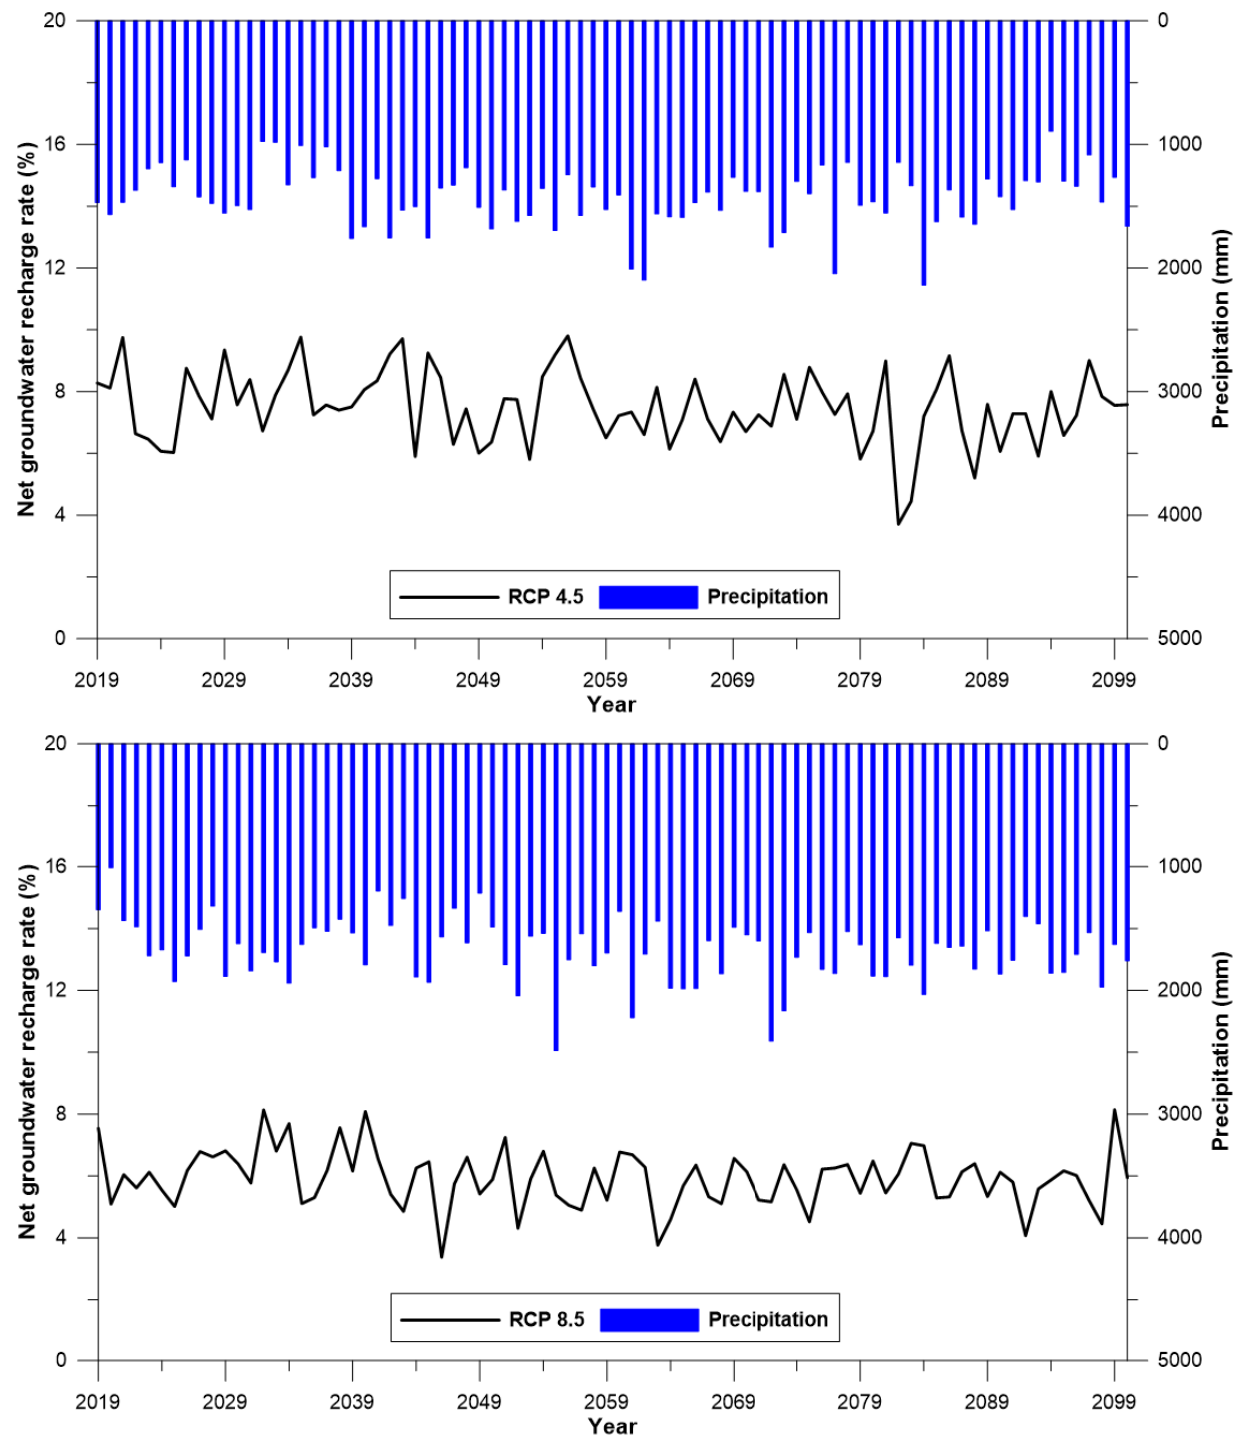
Figure 5. Predicted net groundwater recharge rate in the Nakdong River watershed for 2019 – 2100.